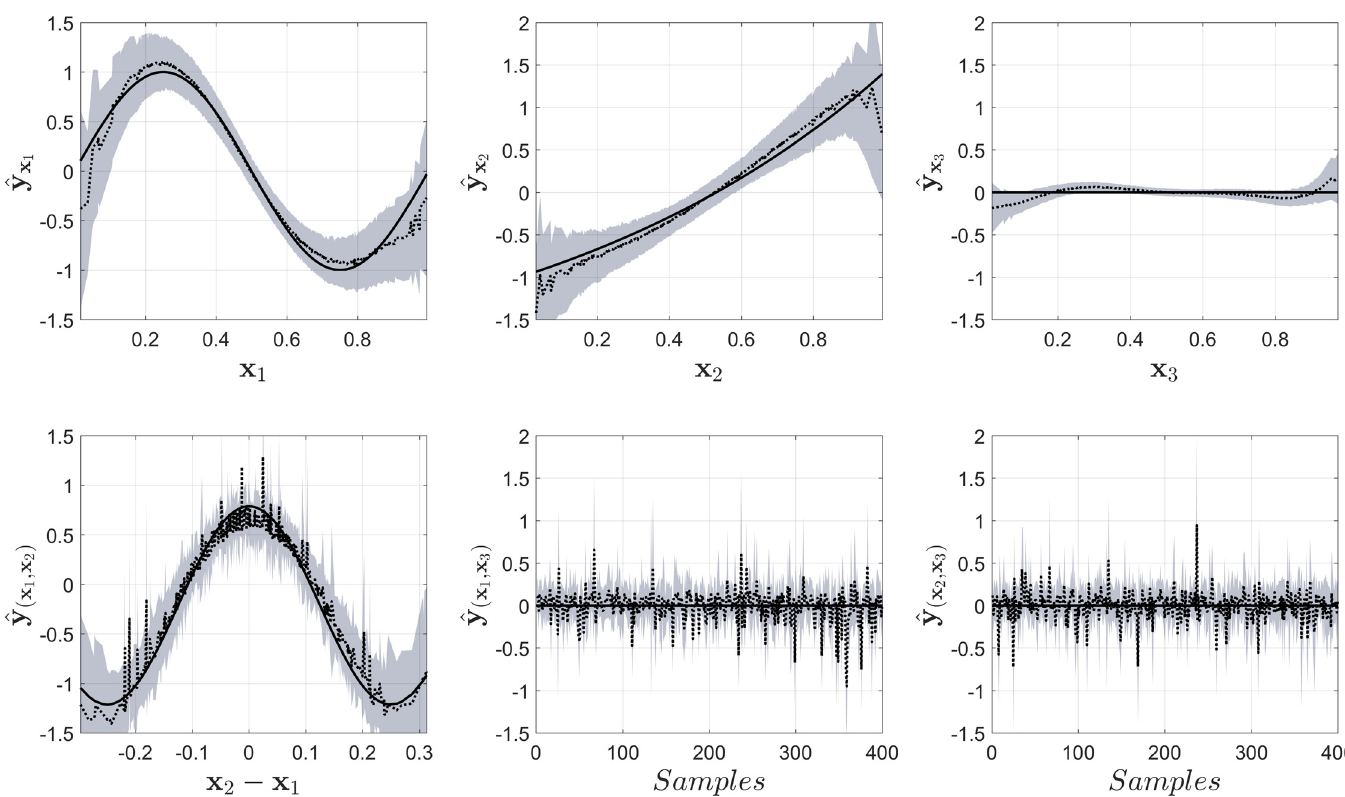
Fig 4. Output from NObSP, the black solid line represents the true component, the dotted black line represents the mean for the estimations using NObSP, and the gray area represents the 95% confidence interval obtaining using